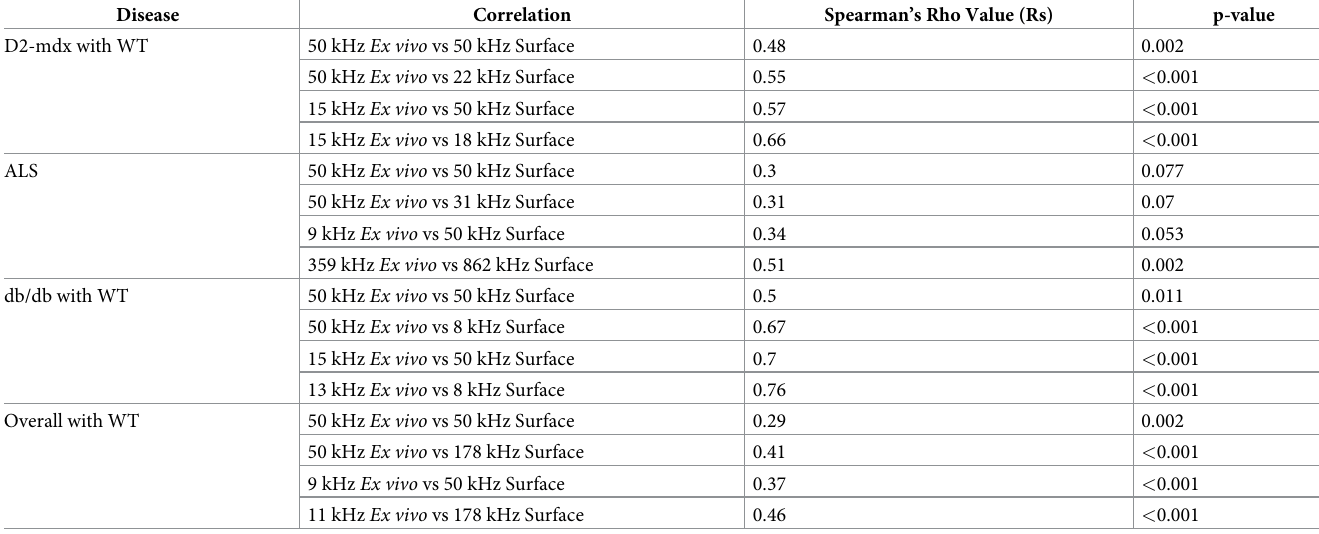
Table 2. Longitudinal reactance (LX) value correlations.